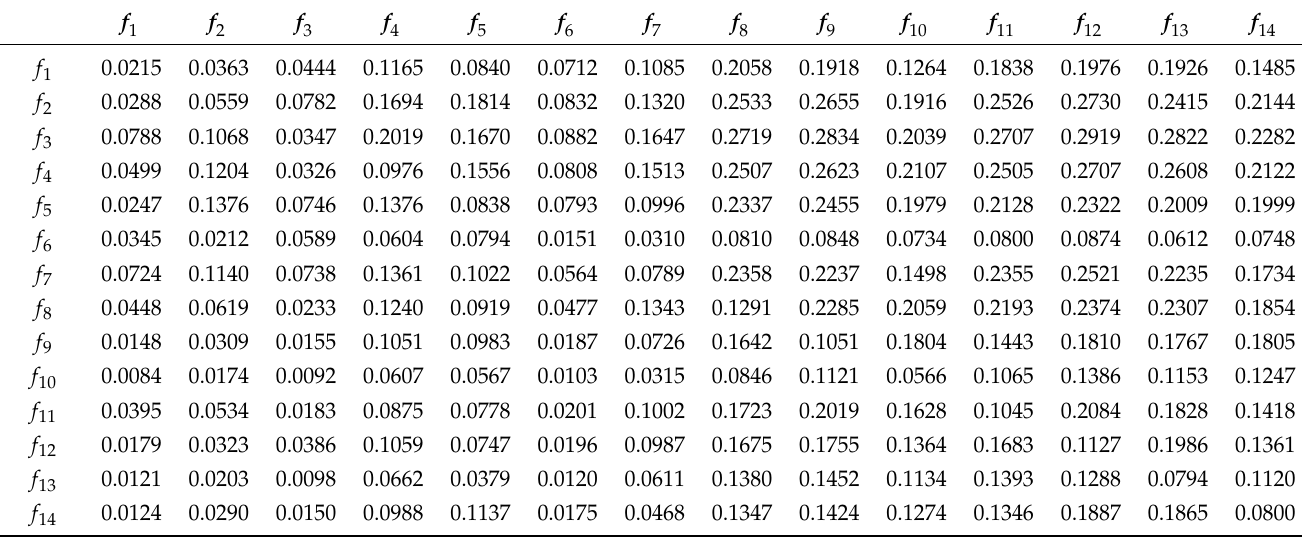
Table 4. The comprehensive influence matrix